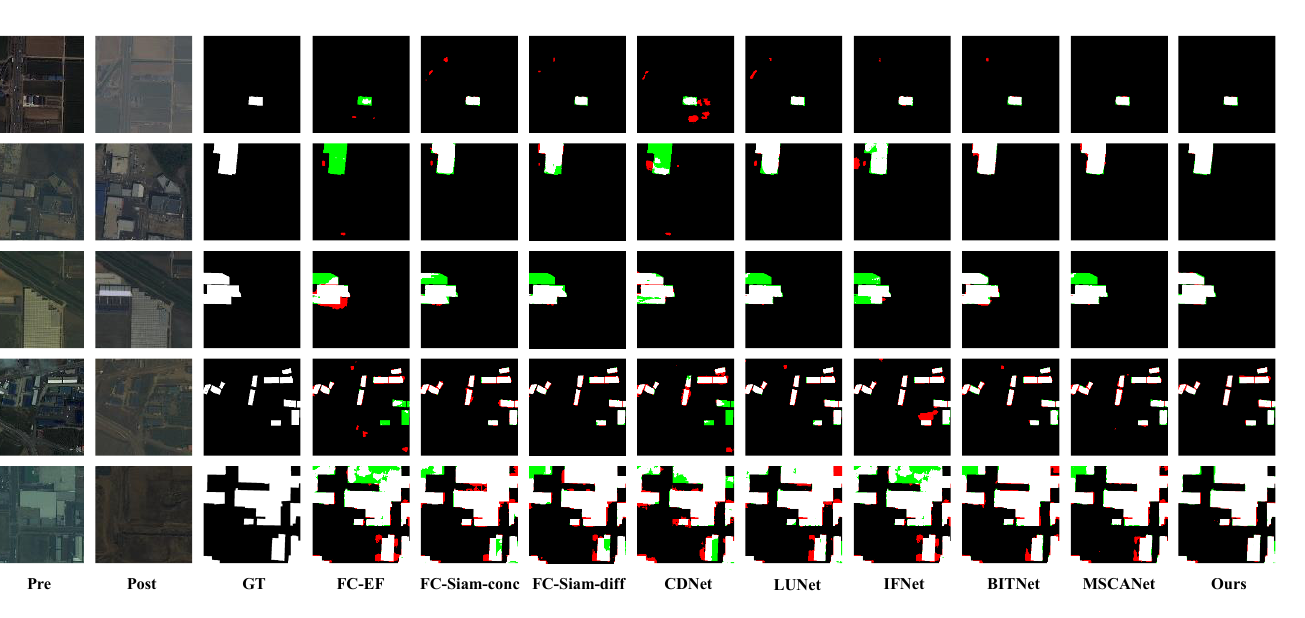
Figure 10. Visualization results of different CD methods in five scenarios from the S2Looking-CD dataset. We plot the FP in red and the FN in green in order to better compare the CD results.